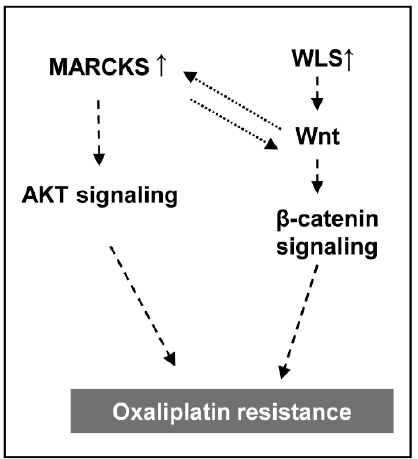
Figure 8. Schematic model of oxaliplatin resistance in pancreatic cancer cells. High expression of MARCKS induced activation of Akt signaling. High level of WLS induced β -catenin pathway by Wnt secretion. The crosstalk of MARCKS and WLS affected increased chemoresistance to oxaliplatin in the pancreatic cancer cell.